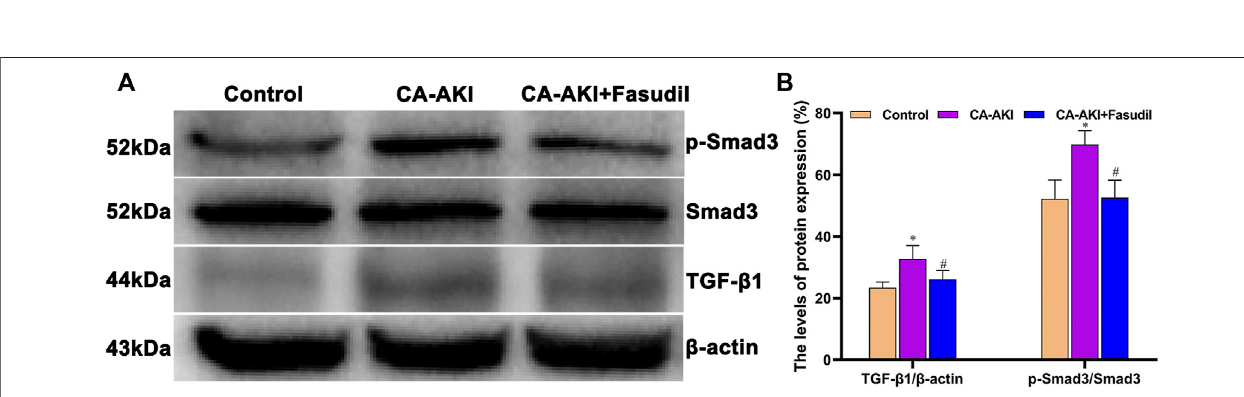
Frontiers in Pharmacology |